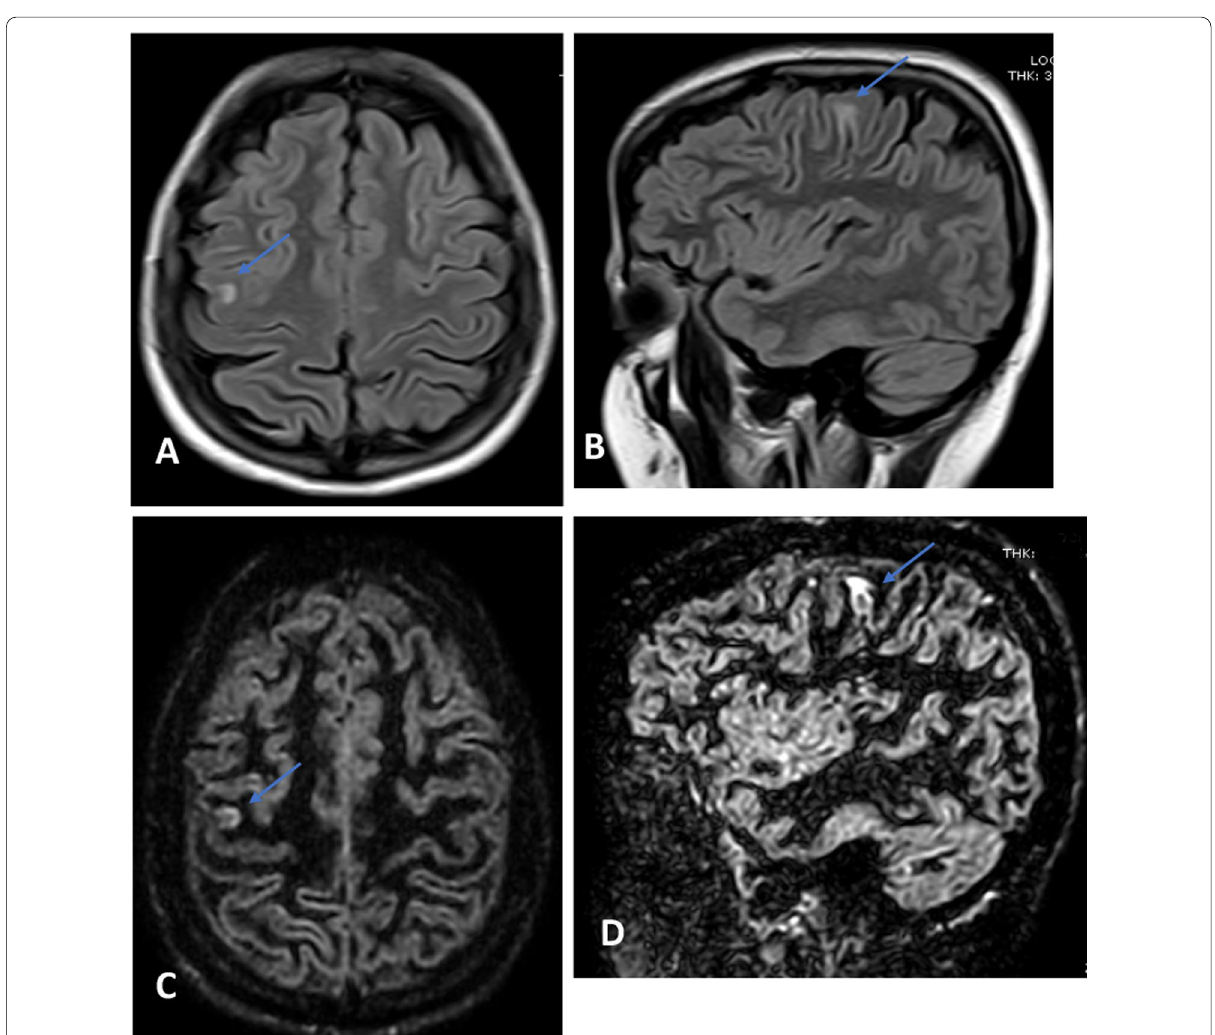
Fig. 5 A 38-year-old female patient with relapsing–remitting MS and EDSS score of 2. A , B Axial and sagittal FLAIR revealed right cortical worm-like type 4 (blue arrow) and two subcortical plaques. C , D Axial and sagittal DIR at the same level clearly defines the right cortical type 4 plaque and the subcortical plaques (blue